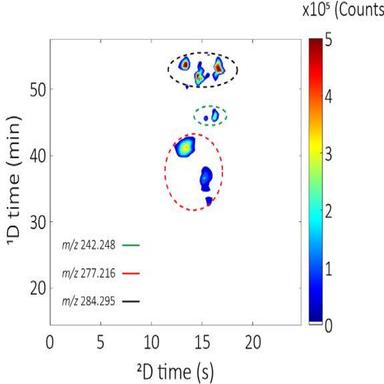
On-line RPLC x SFC-qTOF separation of the full bio-oil sample: EIC 242.248 (green dotted line), 277.216 (red dotted line) and 284.295 (black dotted line). Analytical conditions in 1.